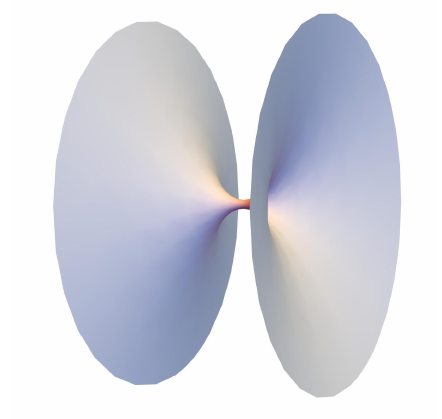
and R , in which the field φ and + −